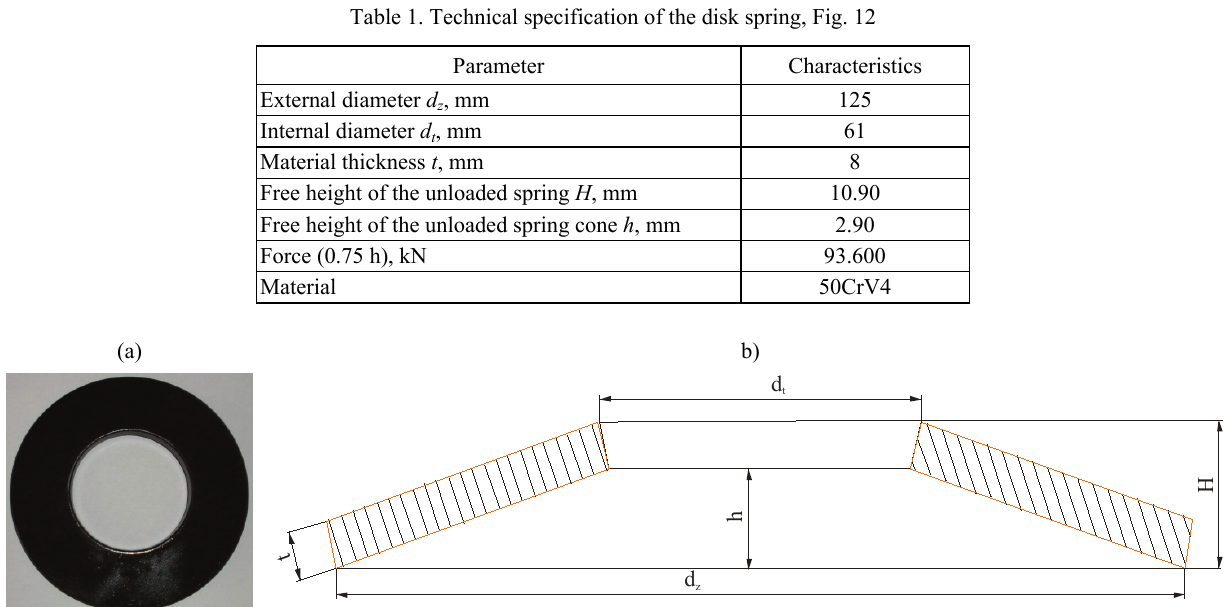
Fig. 12. Disk spring: (a) top view, (b) spring